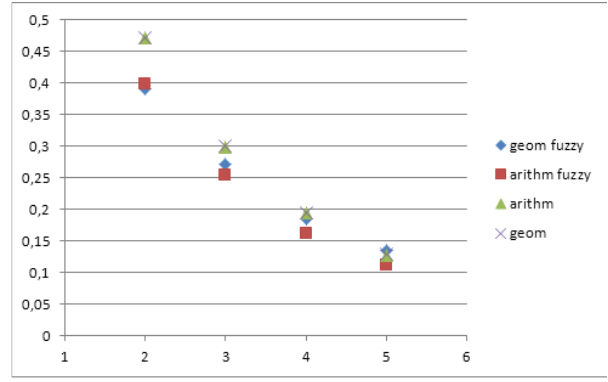
Figure 1. Average error probabilities for 2-5 experts and different aggregation operators. Matrix ˜ P 1 .